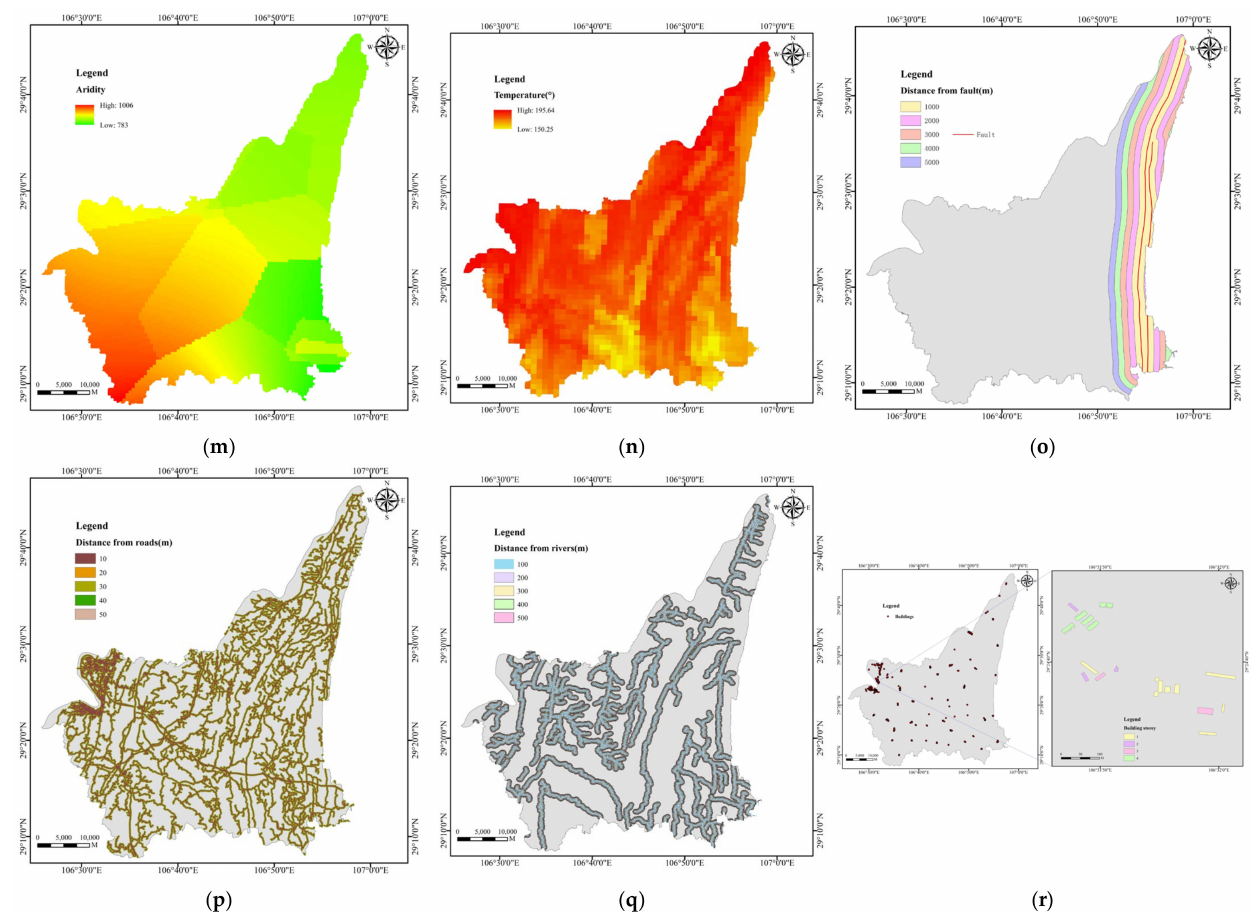
Figure 2. Thematic layers of impact factors: ( a ) Elevation; ( b ) Slope; ( c ) Slope aspect; ( d ) Slope position; ( e ) Curvature; ( f ) Plan curvature; ( g ) Profile curvature; ( h ) Micro-landform; ( i ) TWI; ( j ) TRI; ( k ) Lithology; ( l ) Average annual rainfall; ( m ) Aridity; ( n ) Temperature; ( o ) Distance from fault; ( p ) Distance from roads; ( q ) Distance from rivers; ( r ) Building